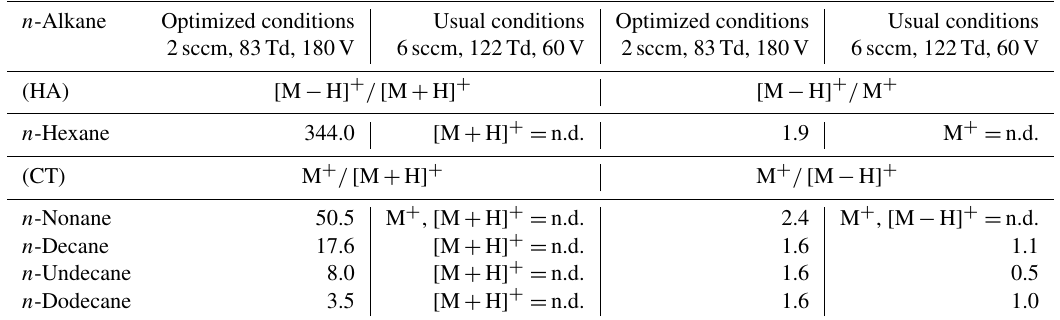
Table 2. Sensitivity ratios for different mechanisms: [M + ] charge transfer, [M − H] + hydride abstraction and [M + H] + proton transfer. Dominant mechanism is shown in parenthesis.